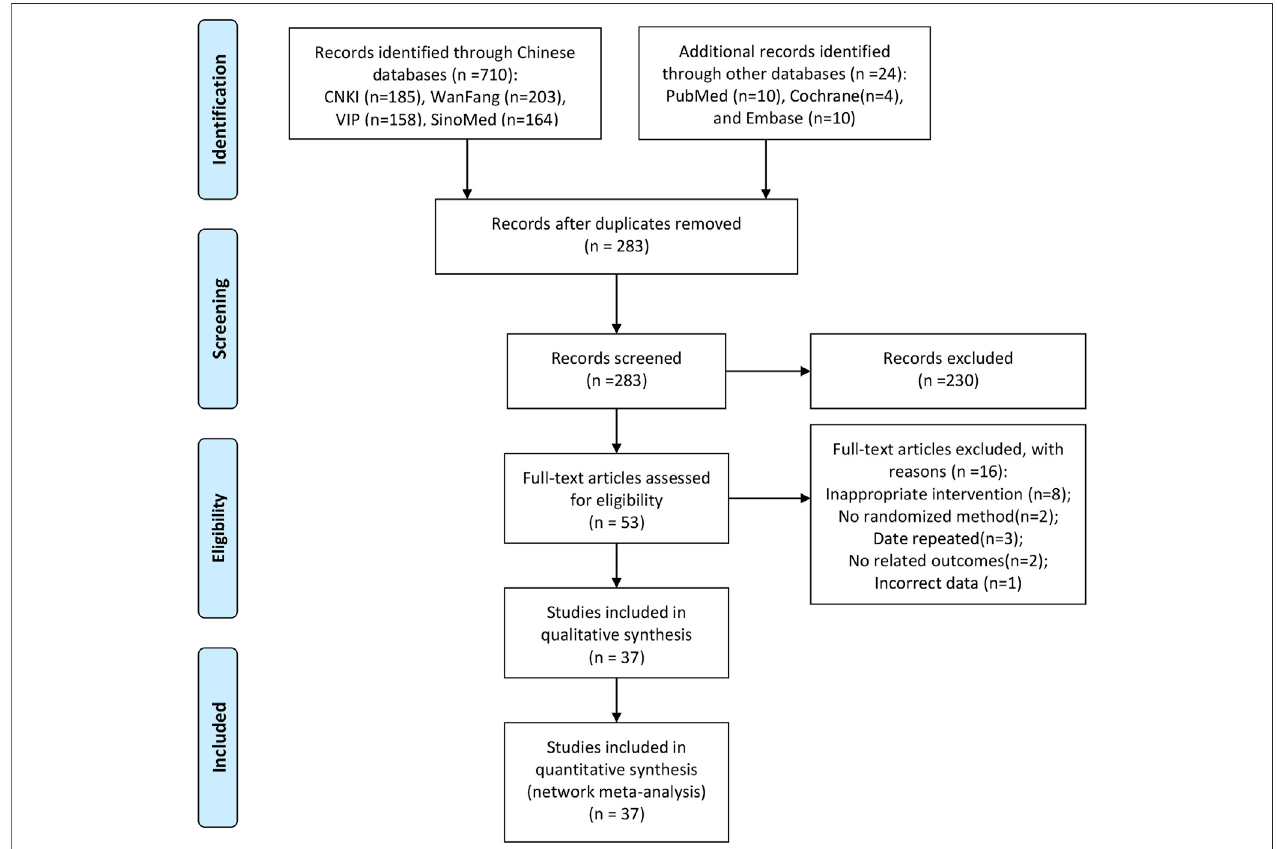
FIGURE 1 | Flow chart of the search for eligible studies. Note: ( n , number of articles. CNKI, China National Knowledge Infrastructure; WanFang, the WanFang Database; VIP, the Chinese Scienti fi c Journals Full-Text Database; and SinoMed, the Chinese Biomedical Literature Database).